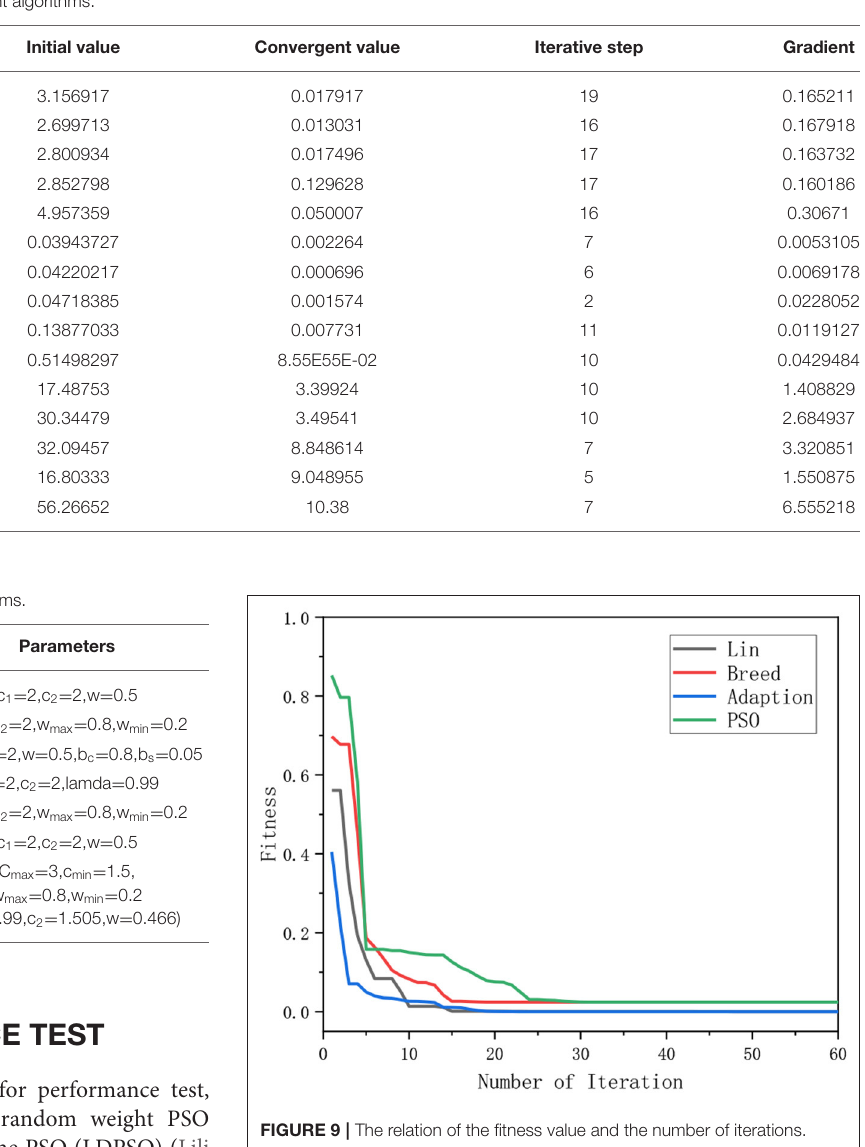
TABLE 3 | The initial and convergent values of different algorithms.